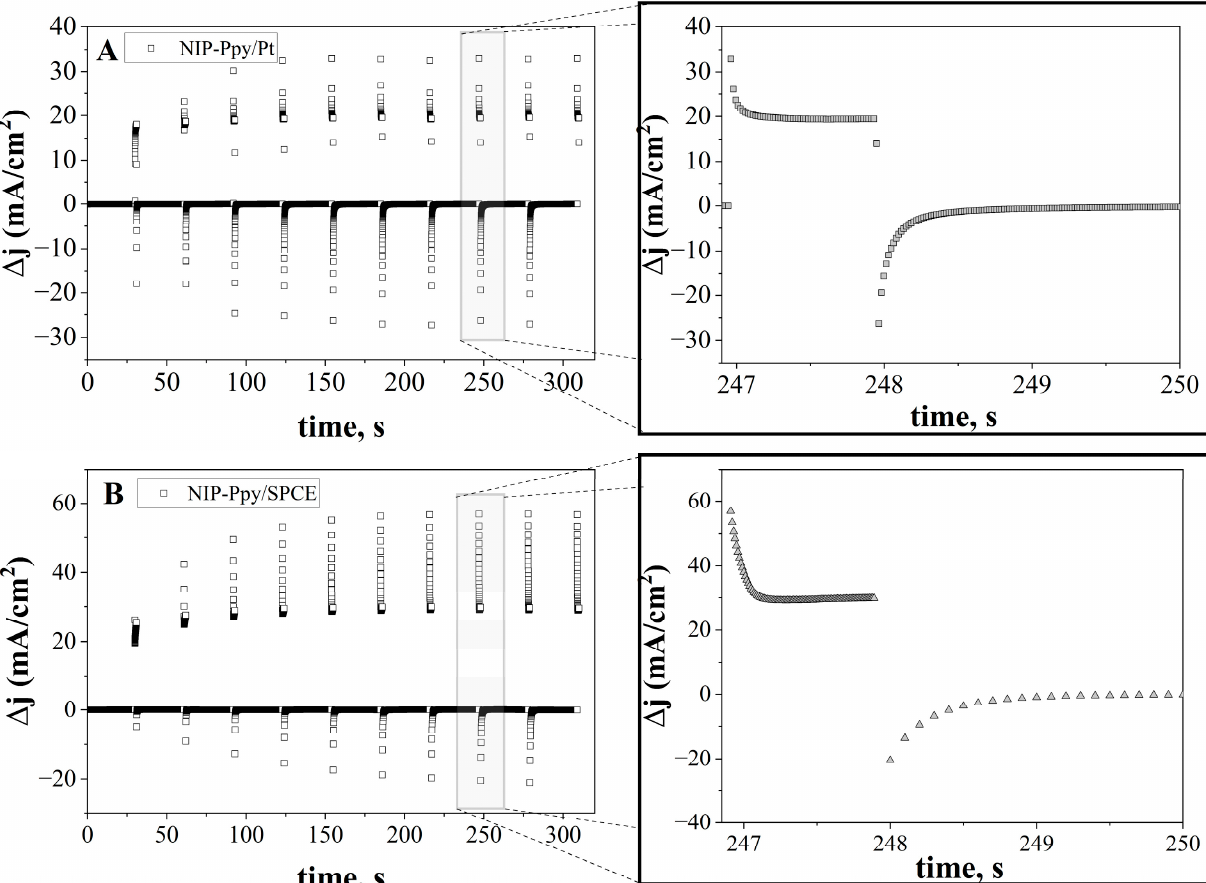
Figure 1. Electrochemical deposition of NIP-Ppy layers: ( A ) on Pt electrodes (second electrochemical system); ( B ) on SPCE electrodes (first electrochemical system), showing the profile of the current registered during the formation of the NIP-Ppy layer from polymerisation solution without any bacteria. Insets—extended profile of the current registered during the indicated potential